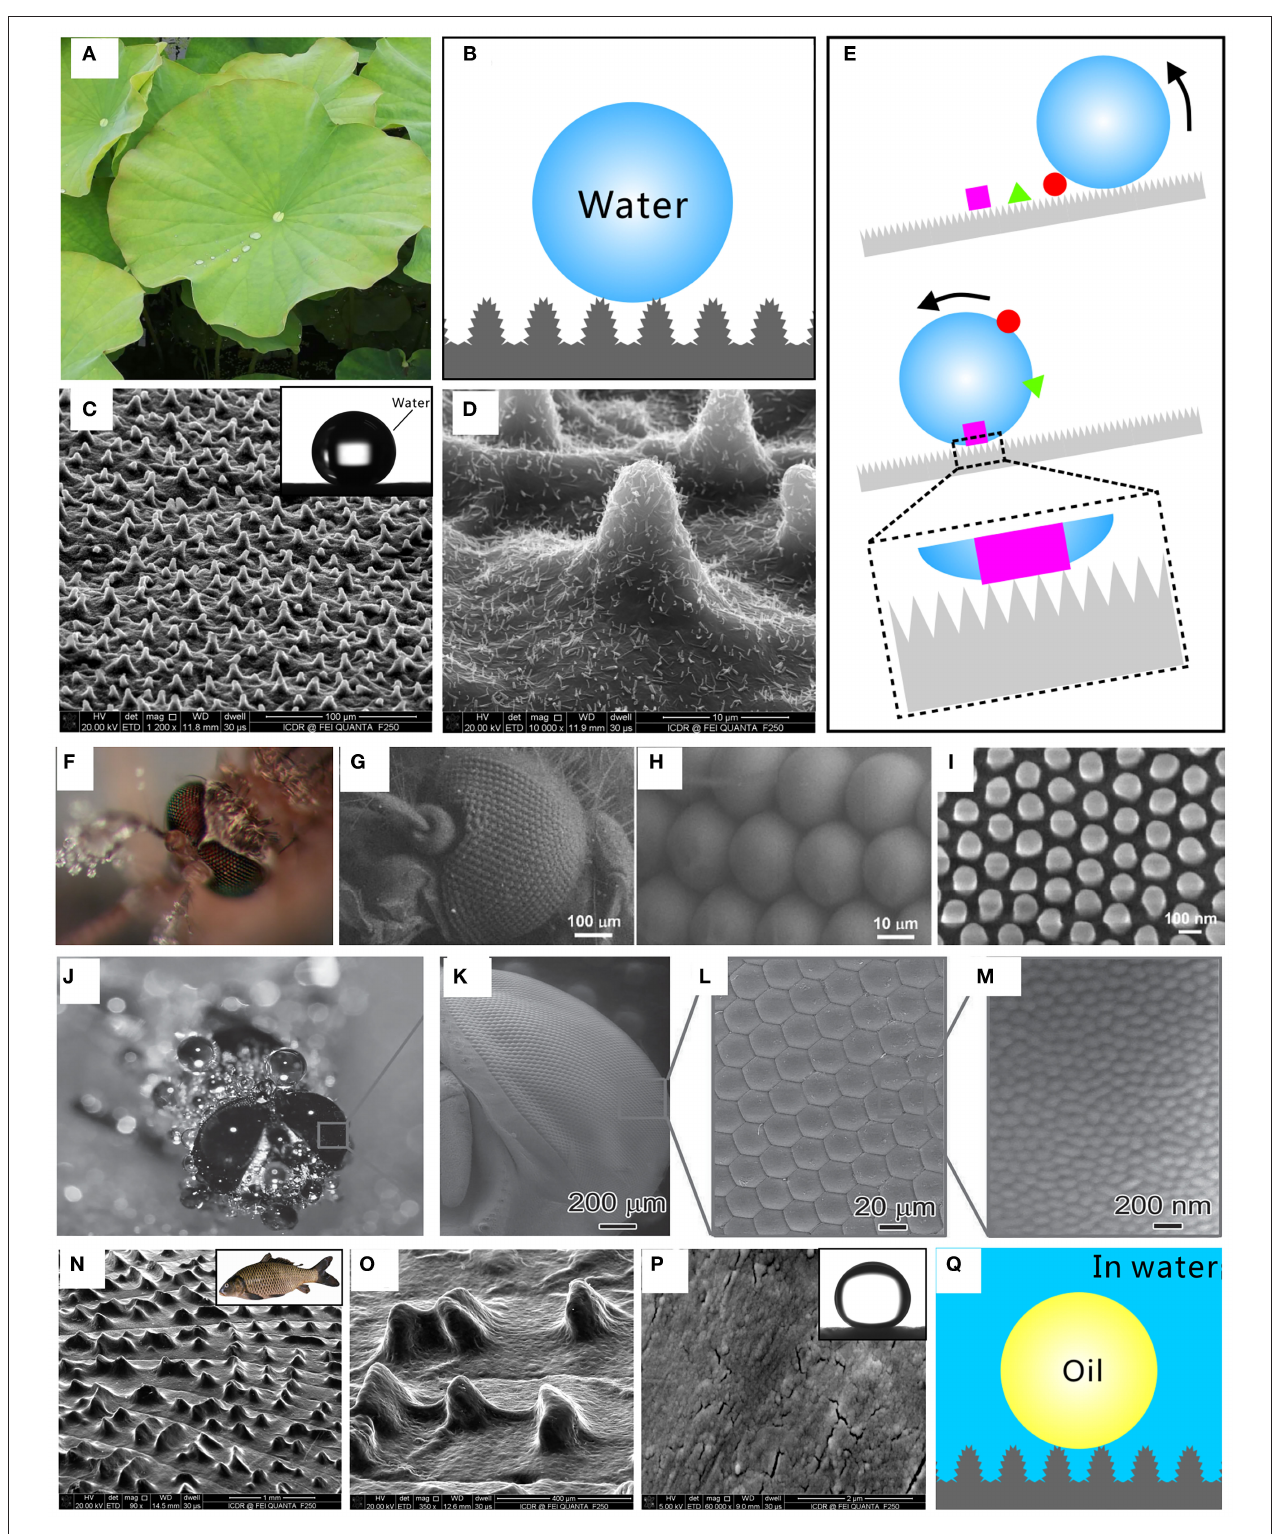
FIGURE 1 | Superwettability in nature. Superhydrophobicity and self-cleaning effect of a lotus leaf surface: (A) photo of lotus leaves, (B) Cassie wetting state between the water droplet and the microstructure of a lotus leaf, (C,D) SEM images of the microstructures on the lotus leaf surface, and (E) schematic of the self-cleaning